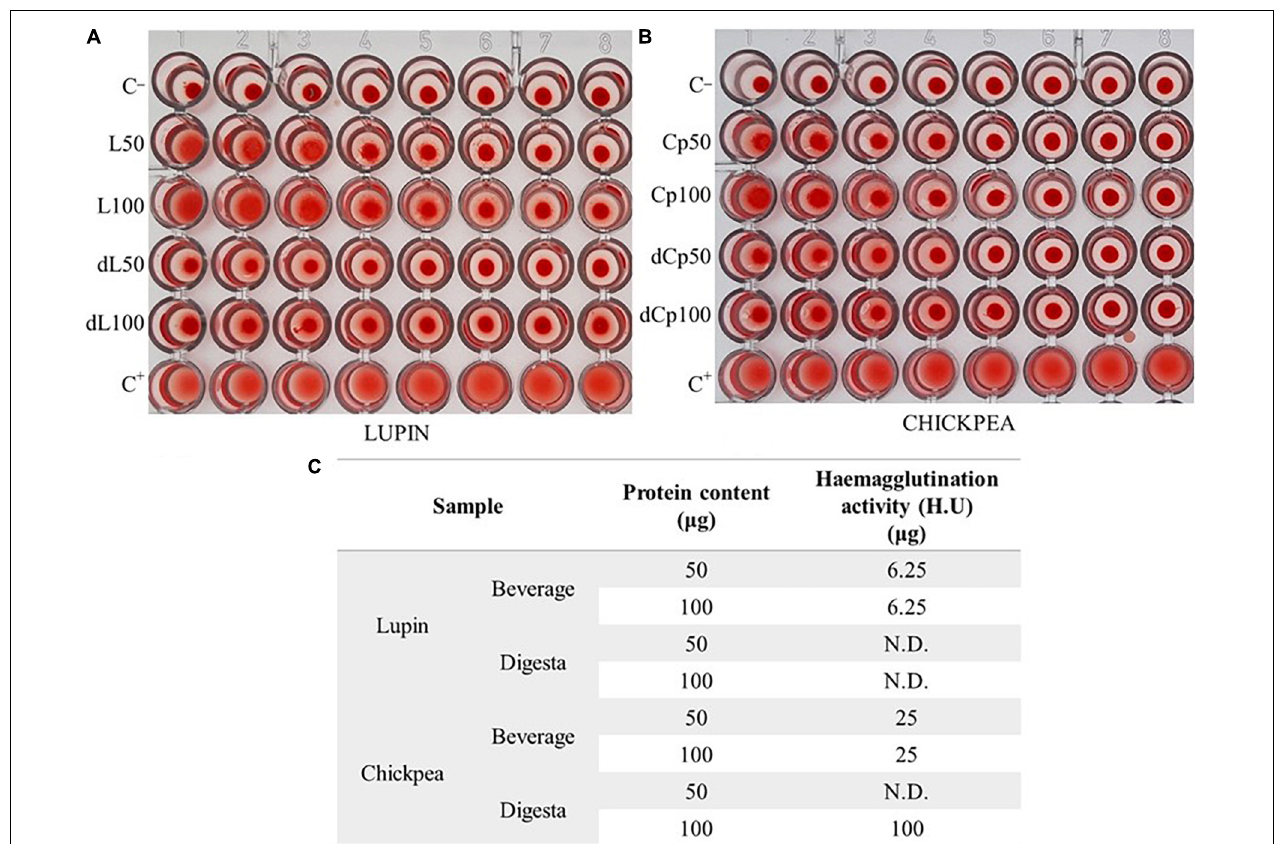
FIGURE 1 | Hemagglutination activity (A,B) : serial dilutions (1:2) of the beverage and digesta extracts (50 or 100 µ g of protein; L, lupin; dL, lupin digesta ; Cp, chickpea; dCp, chickpea digesta ) and negative (C–; saline) and positive (C+; 35 µ g Con-A) controls. (C) Hemagglutination activity H.U. ( µ g) of assayed